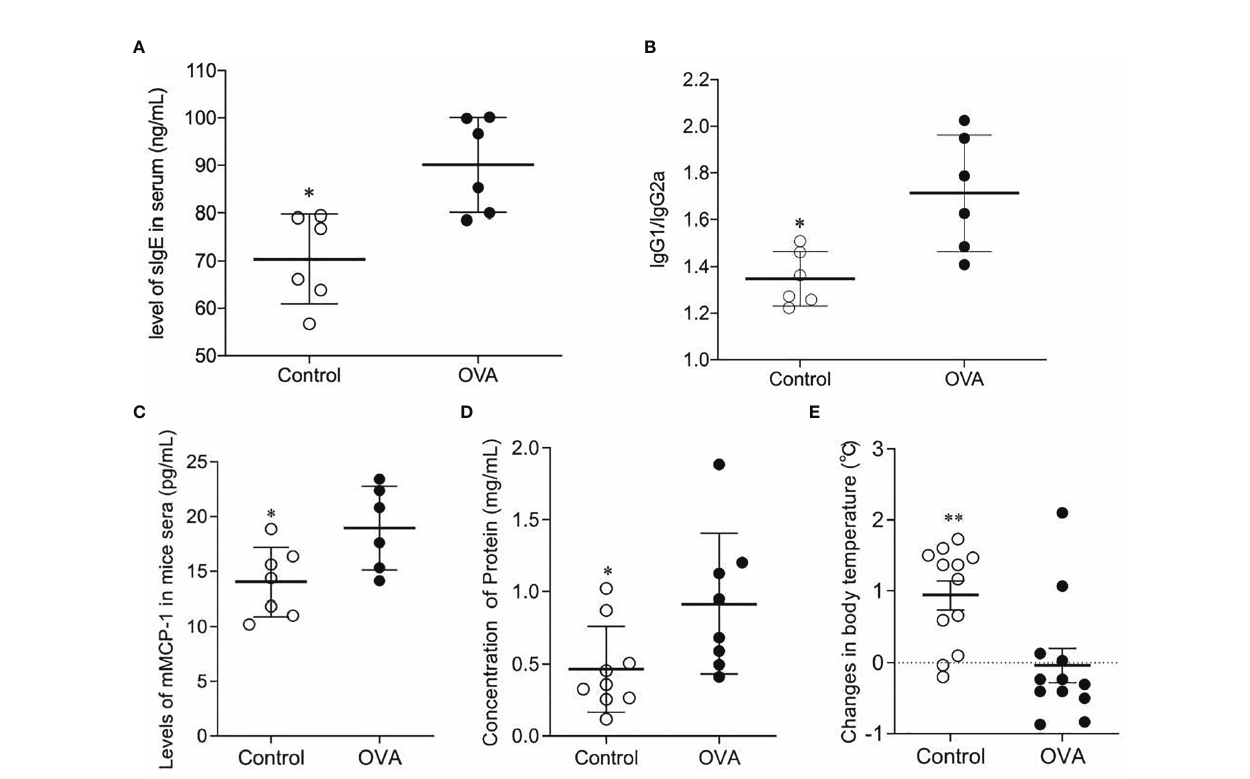
FIGURE 2 | Concentrations of sIgE (A) and ratios of IgG1/IgG2a (B) in sera of OVA-treated (OVA) and saline-treated (Control) mice; Scatter plot of mMCP-1 level of mice serum (C) , protein concentration of peritoneal lavage fl uid (D) and drop of temperature (E) in Control and OVA treated mice. The sera and peritoneal lavage fl uid collection were conducted after the challenge, and protocols were described in Methods . The changes in body temperature were calculated by subtracting the rectal temperature (°C) of mice at 10 minutes before the challenge from the rectal temperature (°C) of mice at 50 minutes after the challenge. One plot denotes one sample, and the bar in the graph denotes Mean and SD. n=6-12/group. *p ≤ 0.05 vs OVA-treated group. Statistical analyses were performed with a two-tailed Student ’ s test. **p ≤ 0.01 vs OVA-treated